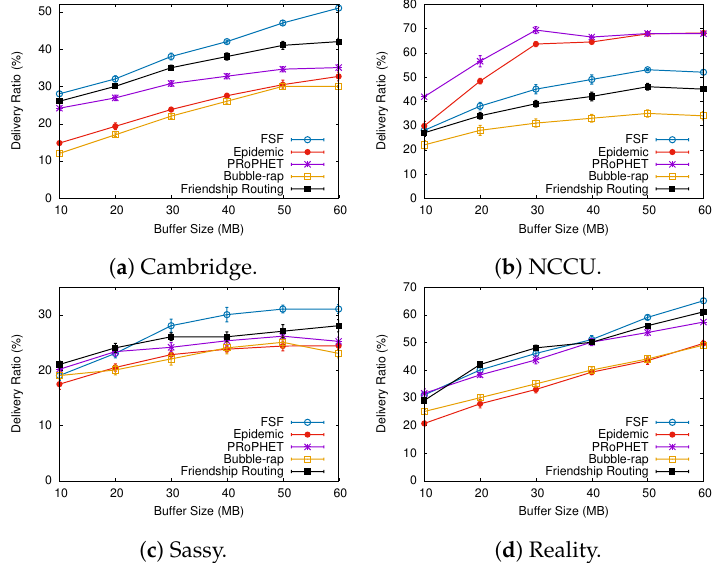
Figure 8. Delivery ratio when varying the buffer size.